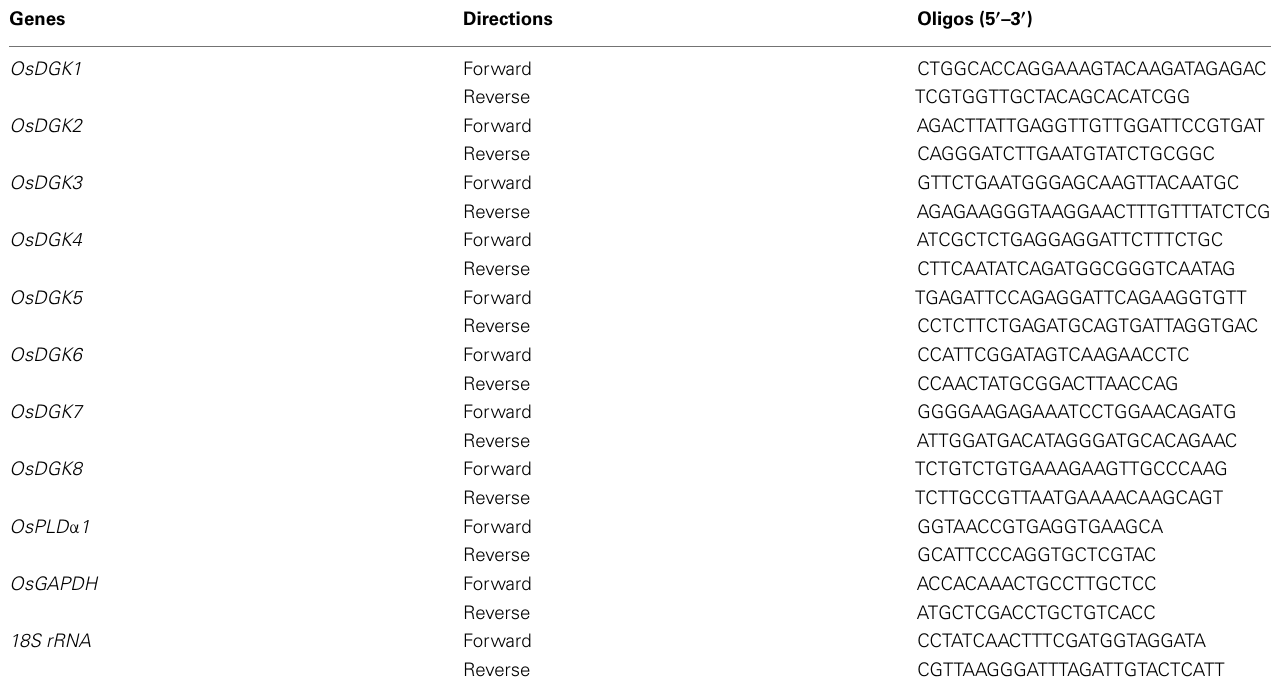
TableA2 | List of oligos used for RT-PCR